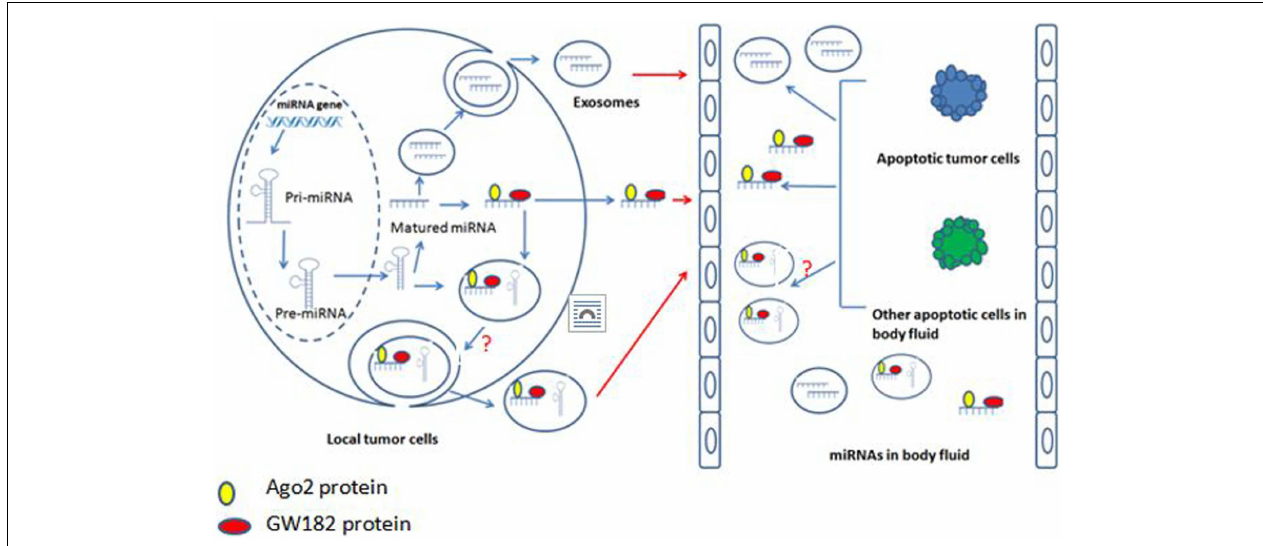
FIGURE 1 |The connection of tumor tissue miRNA, body fluid miRNA, and exosome miRNA .